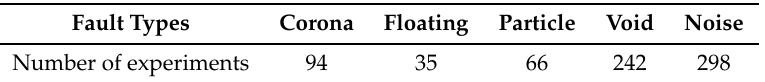
Table 1. Experimental